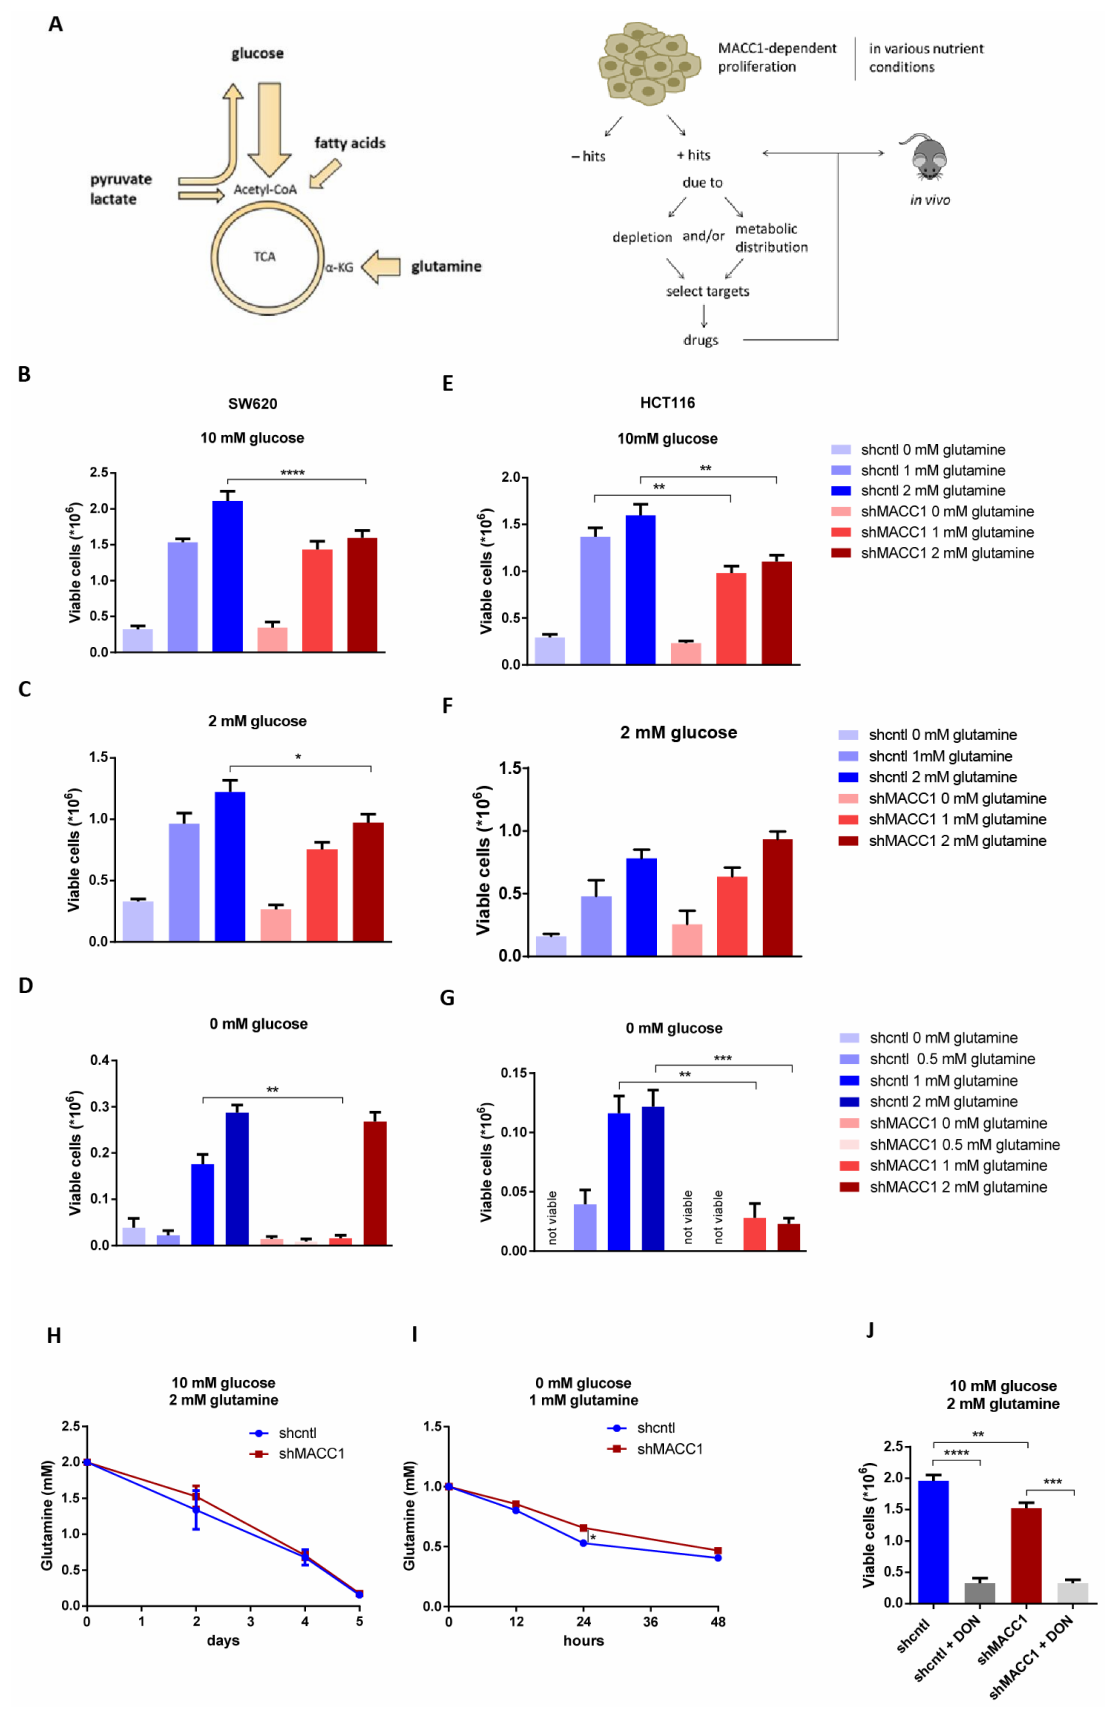
Figure 4. MACC1 impact on glutamine use. ( A ) Schematic representation of metabolic pathways fueled by indicated nutrients and workflow outline for identification of MACC1-dependent nutrient conditions influencing cell